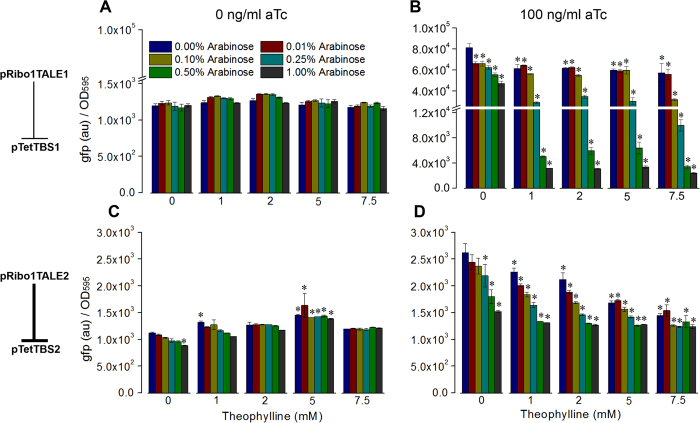
Repression of PTet-based target modules.Response of RiboTALE repression system that consists of (A) RiboTALE module pRibo1TALE1 and target module pTetTBS1 at 0 ng/ml aTc, (B) RiboTALE module pRibo1TALE1 and target module pTetTBS1 at 100 ng/ml aTc, (C) RiboTALE module pRibo1TALE2 and target module pTetTBS2 at 0 ng/ml aTc, (D) RiboTALE module pRibo1TALE2 and target module pTetTBS2 at 100 ng/ml aTc. KD of TALE1, 240 ± 40 nM; KD of TALE2, 1.3 ± 0.3 nM. Error bars represent standard error of the mean (N = 3). Significant differences between the unrepressed (0% arabinose and 0 mM theophylline) and repressed RiboTALE repression systems are indicated by * (p-value <0.05).